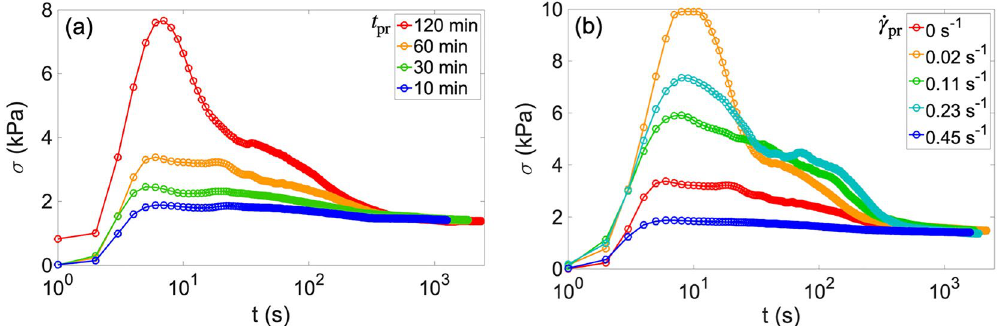
Figure 1. ( a ) Results of SRC tests at ˙ γ src of 1.13 s −1 after various pre-rest times t pr , as shown in the legend. The sample was not sheared during the pre-rest times ( ˙ γ pr = 0 s −1 ). ( b ) Results of SRC tests at ˙ γ src of 1.13 s −1 after t pr = 60 min at various ˙ γ pr , as shown in the